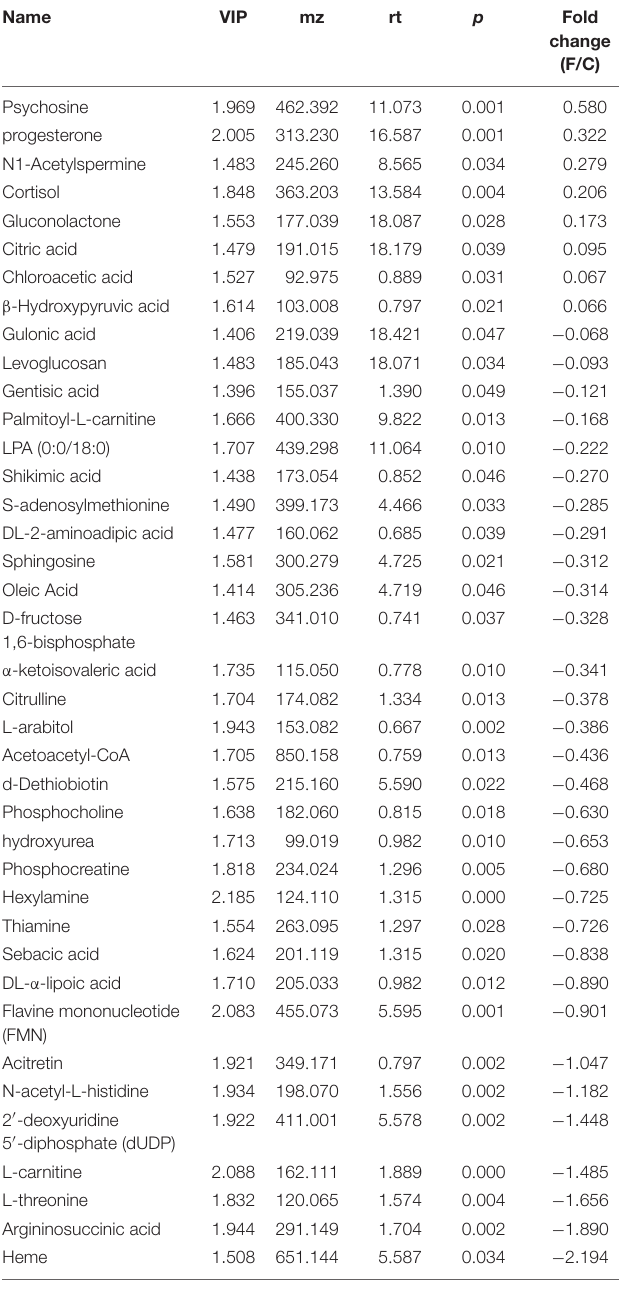
TABLE 3 | Differential BALF metabolites on 7 dpi. TABLE 4 | Differential BALF metabolites on 28